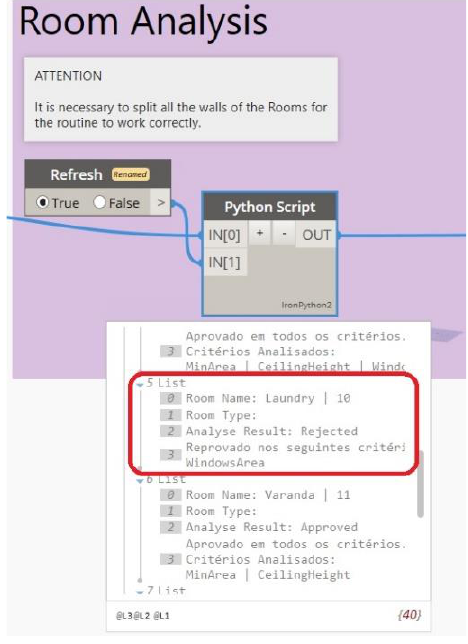
Figure 10. Individual output analysis (SF building).